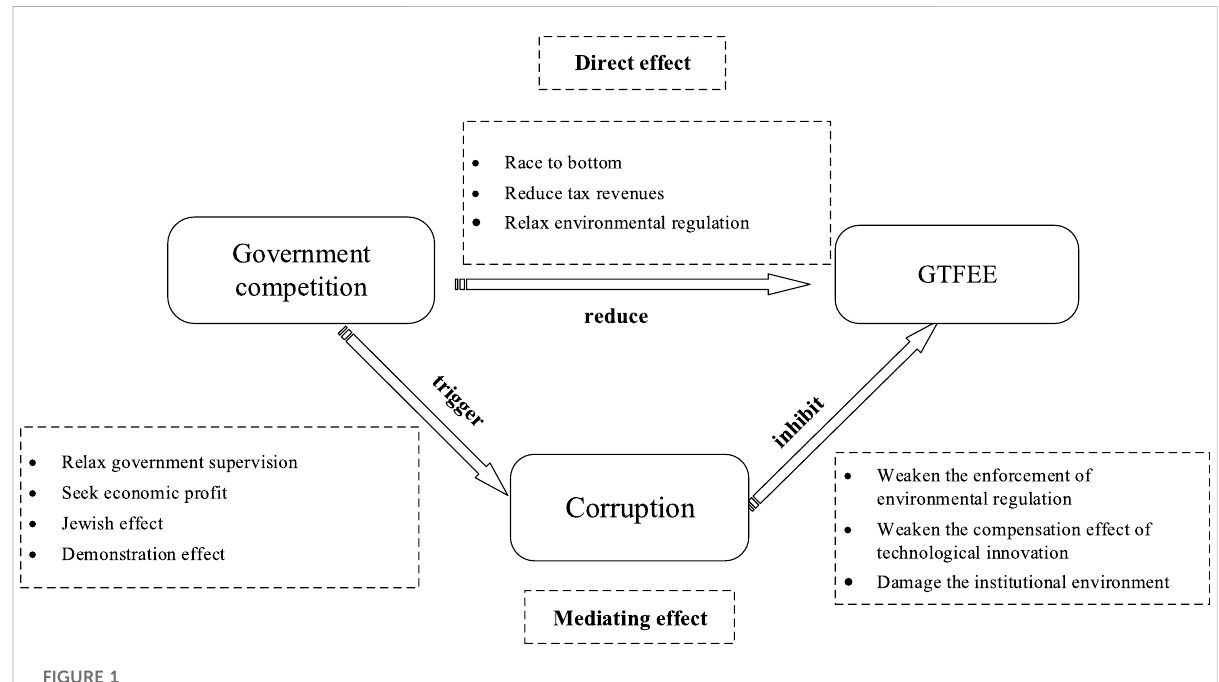
FIGURE 1 The mechanism analysis of government competition, corruption, and